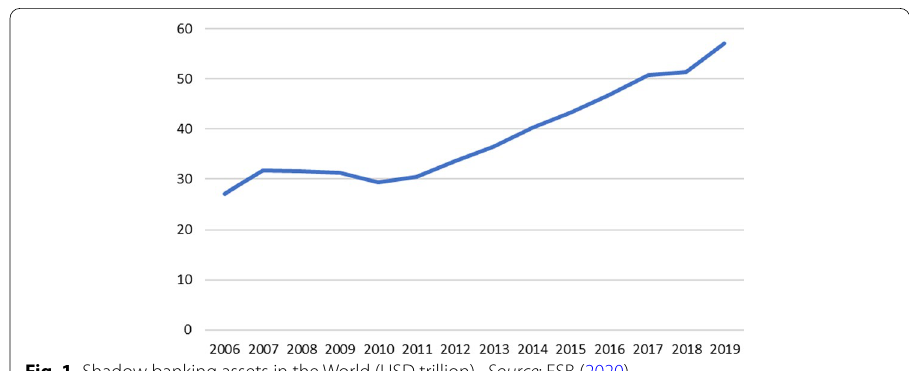
Fig. 1 Shadow banking assets in the World (USD trillion). Source : FSB